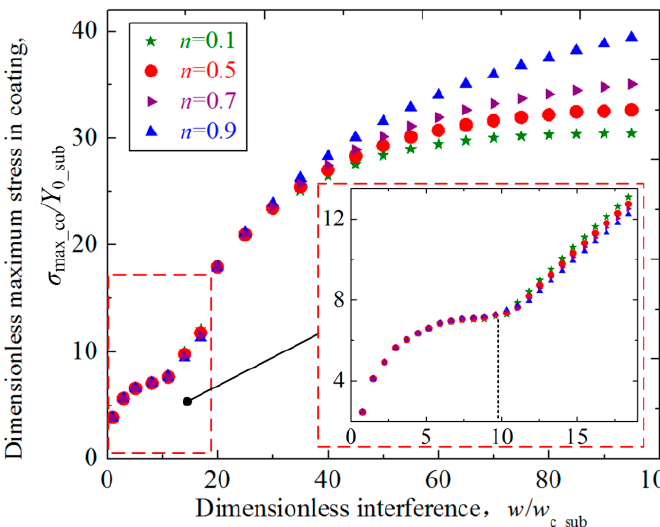
Figure 8. The relation between the dimensionless maximum von Mises stress σ max_co /Y 0_sub in the coating and the dimensionless interference w / w c_sub for some typical cases where dimensionless coating thickness t/R = 0.01, Young’s modulus ratio E co /E su = 4 at selected hardening exponents of the substrate n = 0.1, 0.5, 0.7, 0.9.